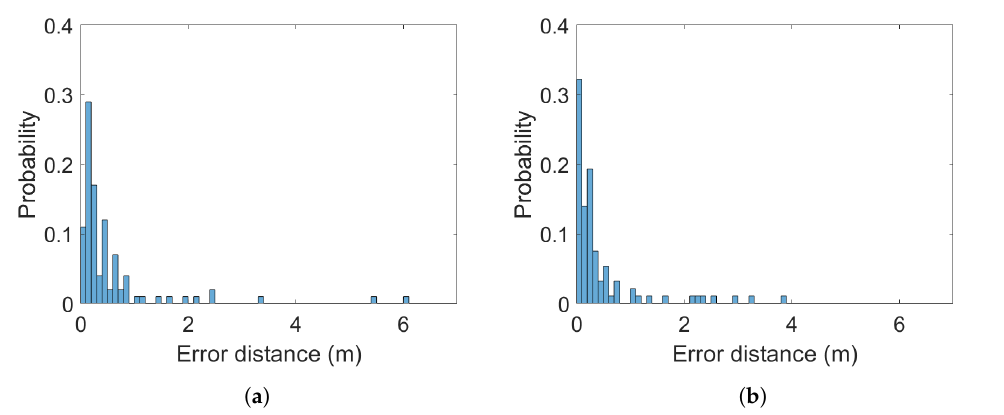
Figure 7. Histograms of error distances across all ground-truth points for ( a ) Pozyx and ( b ) GoT for 0.3 m altitude (bins: 0.1 m).